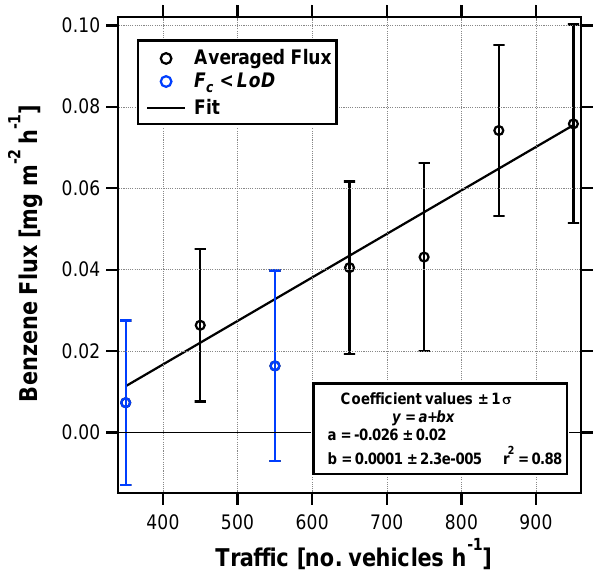
Figure 11. Benzene flux measurements calculated using a pre- scribed time lag and averaged as a function of traffic density. Error bars represent the ensemble LoD. In cases where the error bars in- tersect zero (blue points), the flux cannot be considered significantly different from